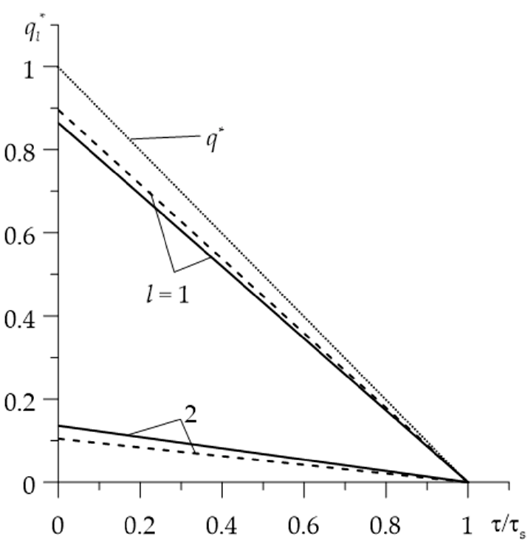
∗ ( τ ) , l = 1,2 during braking with q , 2,1 = l during braking with l l ∗ q .